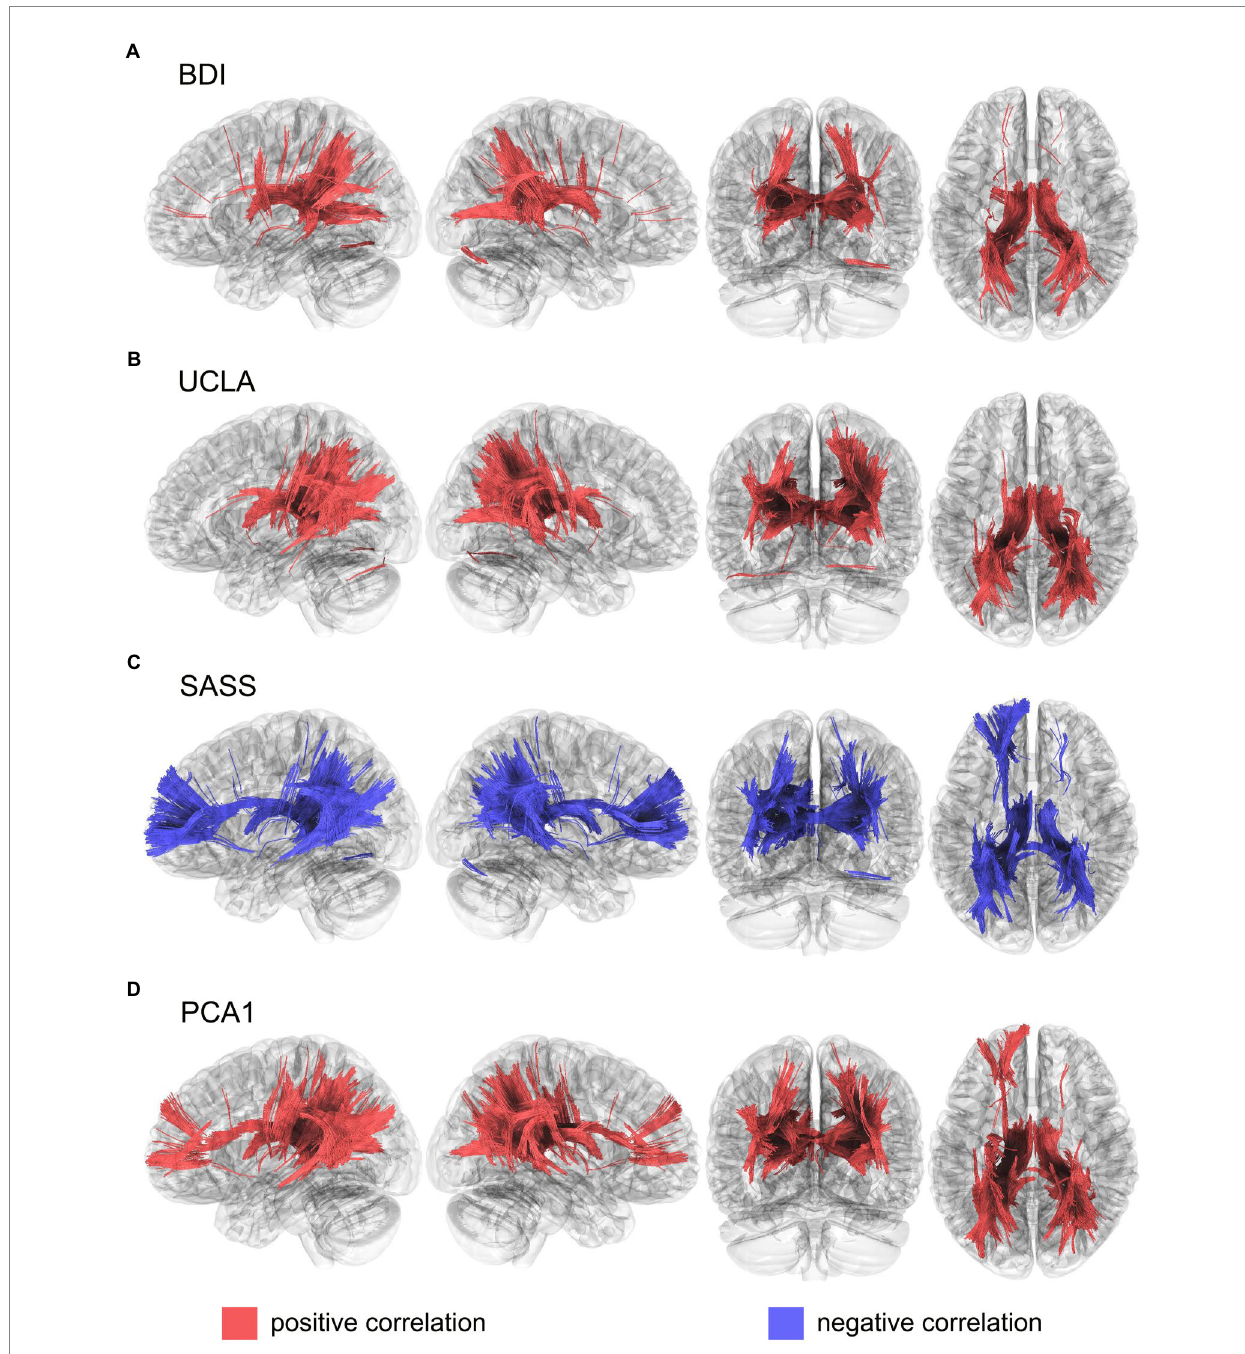
FIGURE 1 Structural connectivity correlates of (A) . BDI, (B) . UCLA, (C) . SASS and (D) . PCA1, calculated using mean diffusivity index from a diffusion tensor imaging model. Results were corrected with a p < 0.05 FDR. BDI, Beck depression inventory; SASS, social adaptation self-administered scale; UCLA, University of California loneliness scale; PCA1, first component from a principal component analysis that includes BDI, UCLA and